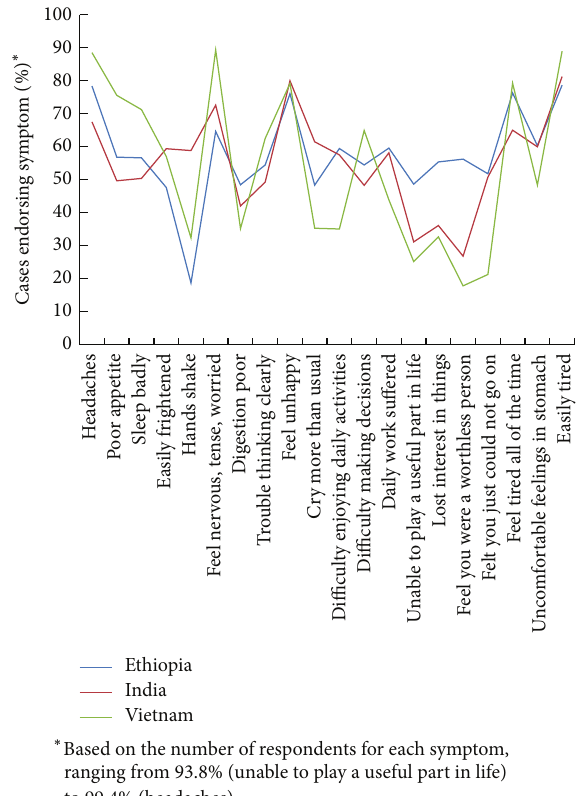
Figure 1: Prevalence of SRQ-20 symptom endorsement ∗ in those identified as probable maternal CMD cases, by